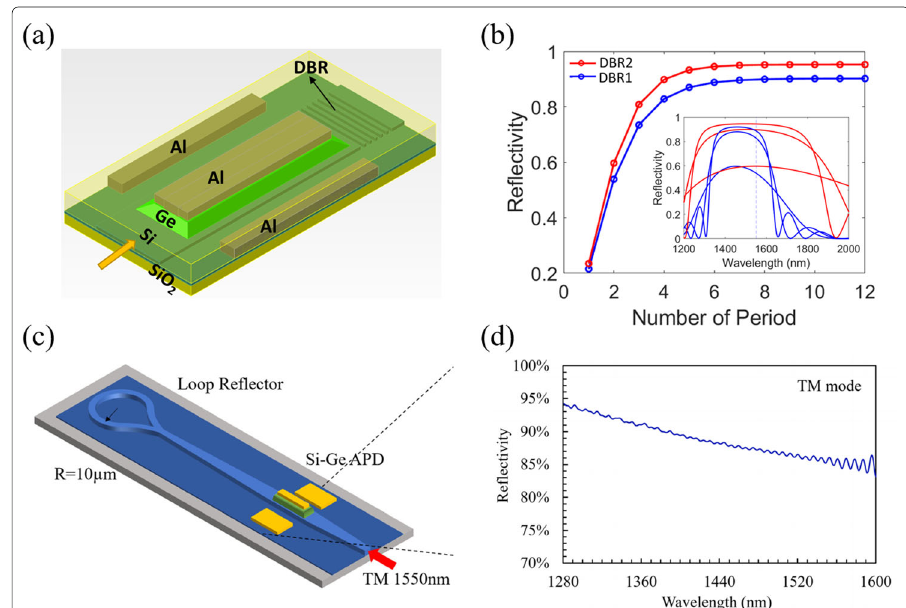
Fig. 7 a Schematic of the waveguide-coupled low-voltage Si-Ge vertical SACM APD integrated with a distributed Bragg reflector and b Reflectivity versus number of period for two DBR designs. Inset is the reflectivity spectra for the two types of DBRs with 2, 4, and 6 periods, respectively [100]; c Schematic of the waveguide-coupled low-voltage Si-Ge vertical SACM APD integrated with a loop reflector and d Reflectivity spectrum of the loop reflector